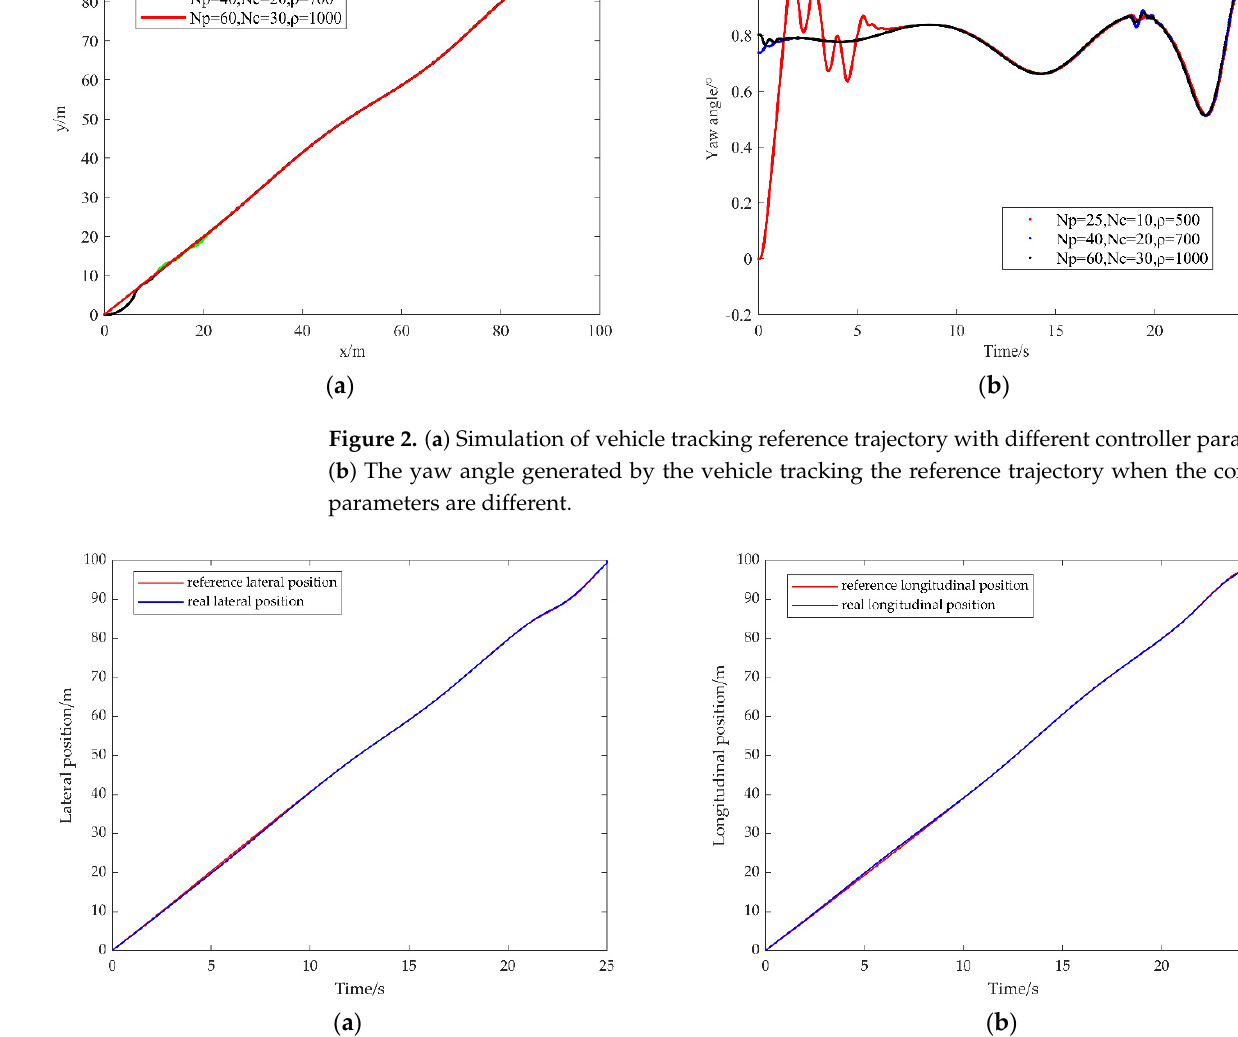
Figure 2. ( a ) Simulation of vehicle tracking reference trajectory with different controller parameters; ( b ) The yaw angle generated by the vehicle tracking the reference trajectory when the controller parameters are different.